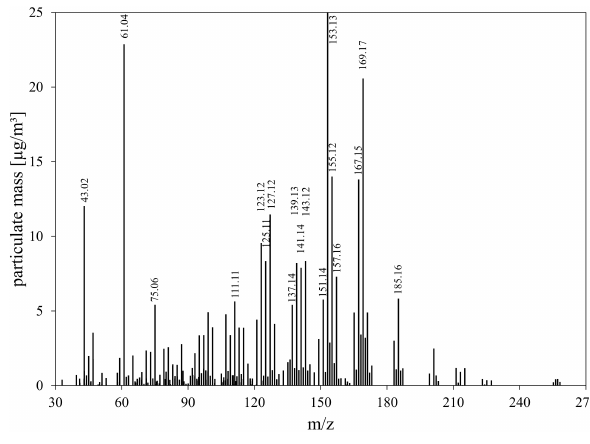
Figure 4. PTR-ToF-MS mass scan obtained from ozone–limonene SOA sampled with the CHARON inlet. Note that the particulate mass is enriched by a factor ∼